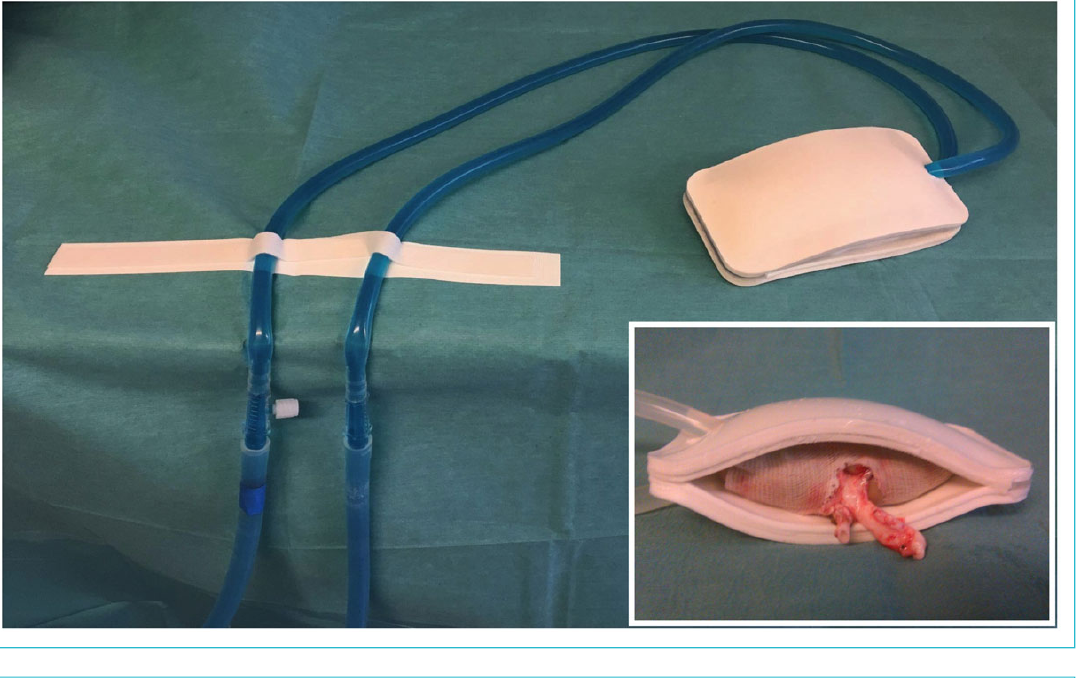
Figure 2: Temperature curve from procurement to reperfusion. Curve (left) and slope during anastomosis (right) in the control or cooling group (n = 6–7). Errors bars indicate the standard error of the mean. * p <0.05; Ctrl =